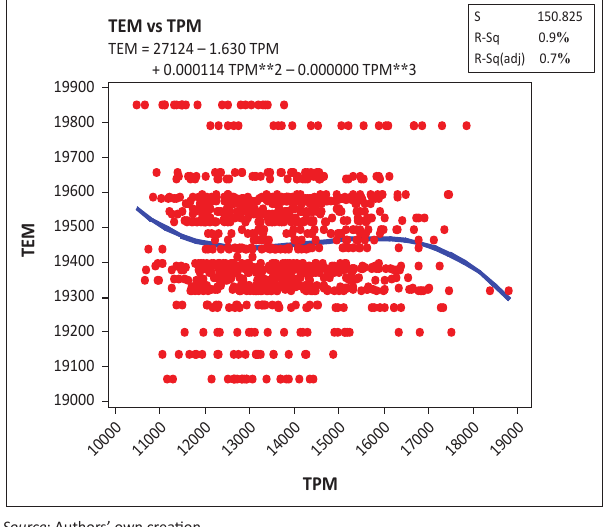
FIGURE 6: Regressions for total hours of breakdown services and total hours of preventative maintenance services from the first